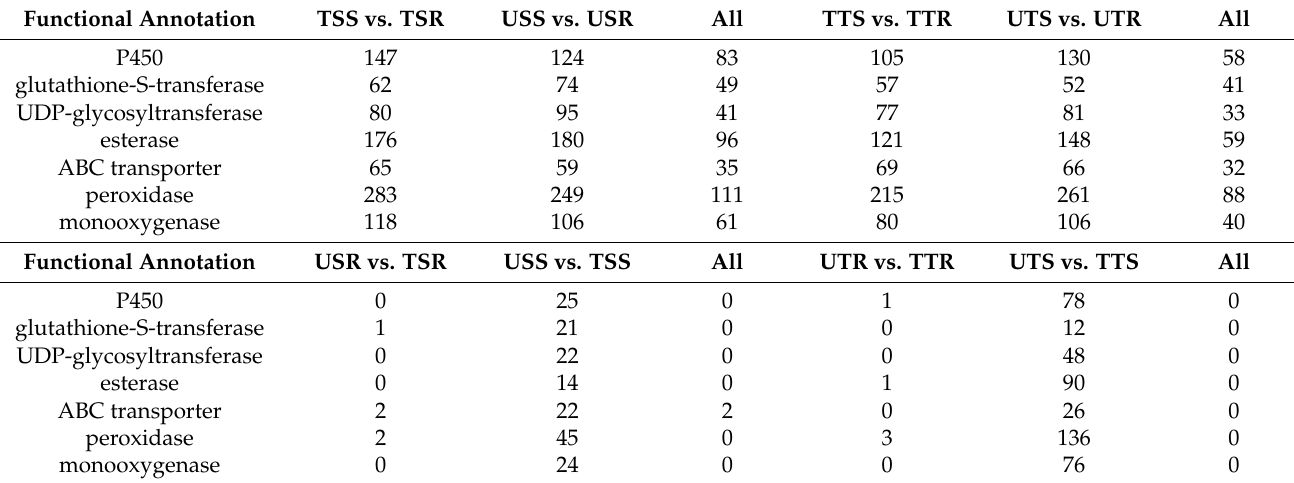
Table 1. The number of differentially expressed NTSR genes within groups and in inter-groups in the seedling and tillering